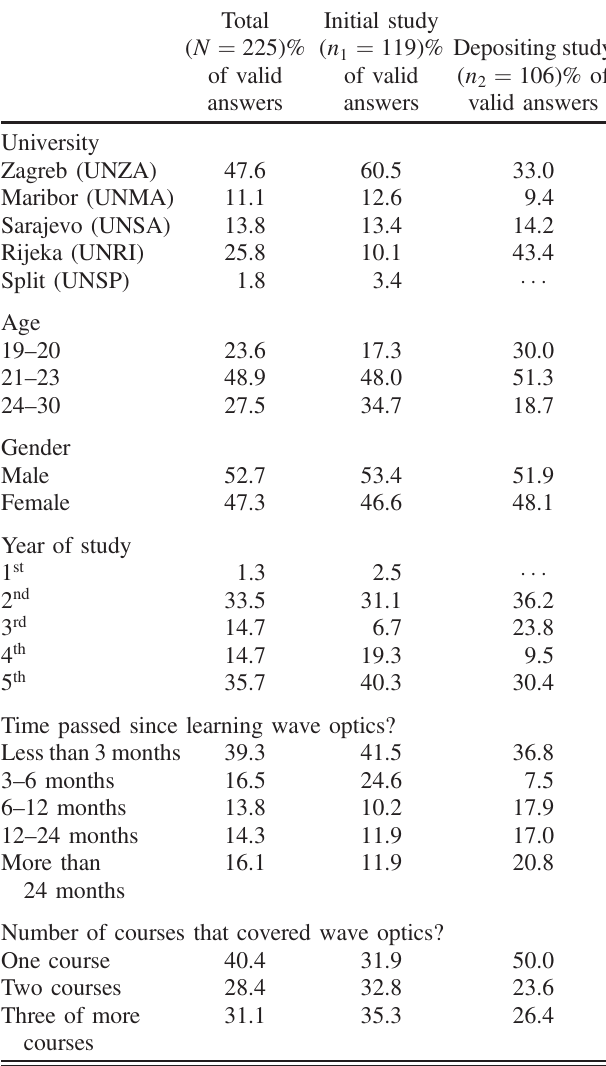
TABLE I. Characteristics of the student samples in the initial and depositing